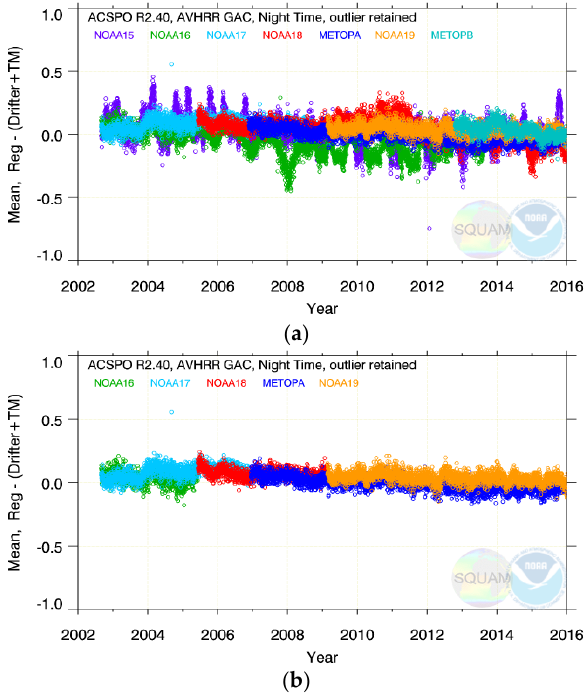
Figure 1. Mean nighttime Δ T S = T S − T in situ for T S derived using static regression coefficients: ( a ) all data; ( b ) used in RAN1. Each data point represents a daily statistic based on matchups with in situ SSTs (from 500 to 2000; cf . discussion in Section 2.4).